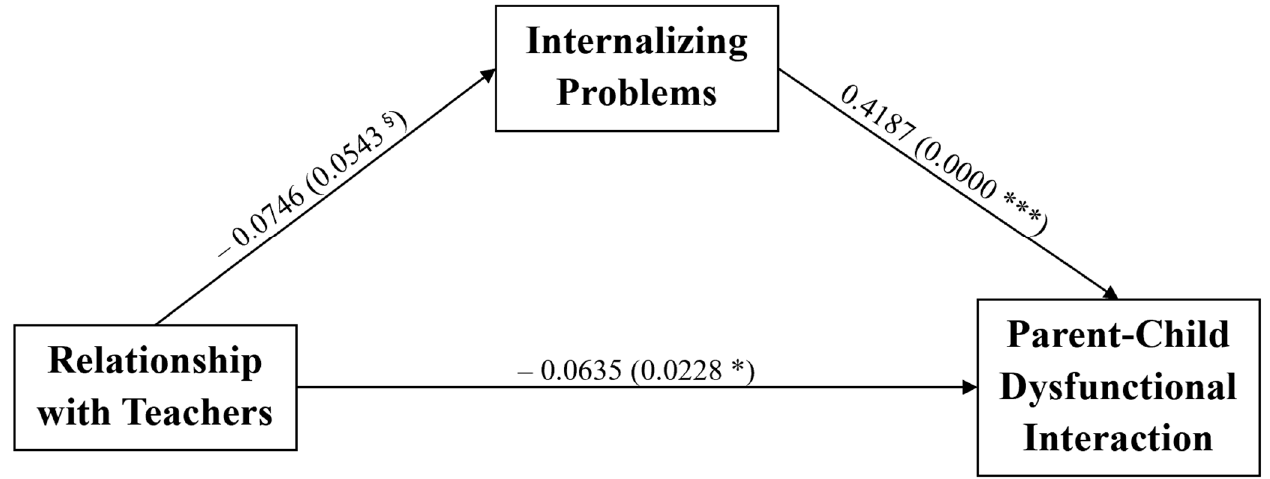
Figure 1. Multiple mediation model on the association between the relationship quality with peers, internalizing problems and the PSI-4-SF parent–child dysfunctional interaction subscale. The effect of the children’s relationship with teachers on the parent–child dysfunctional interaction is mediated via the internalizing problems of the child. § 0.05 < p -value < 0.06; * p -value < 0.05; *** p -value < 0.001.